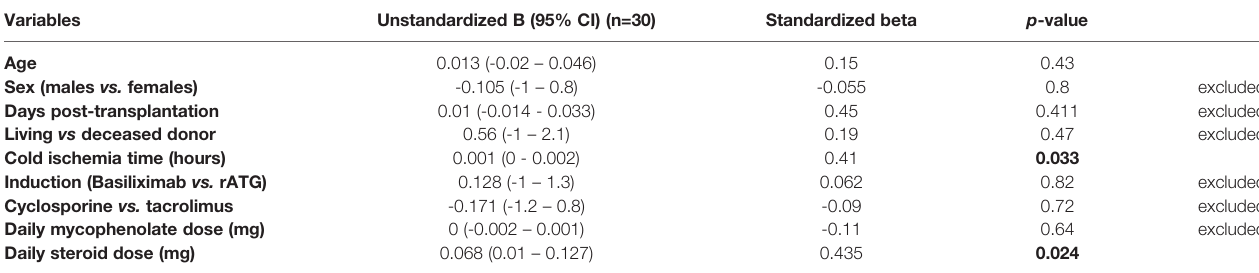
TABLE 8 | Multiple linear regression analysis of the factors affecting relative CD19+IL-10+ Breg counts in early renal transplant recipients.